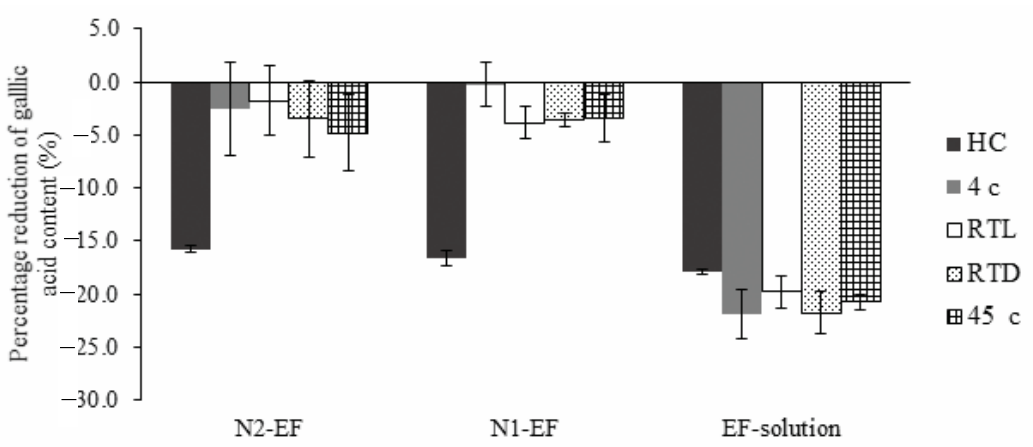
Figure 5. Percentage reduction of gallic acid content from the initial point (D0) of extract-loaded nanoemulsions (N1-EF and N2-EF) and the extract solution (EF-solution) evaluated using HPLC analysis after storage in various conditions (mean ± SD; n = 3).